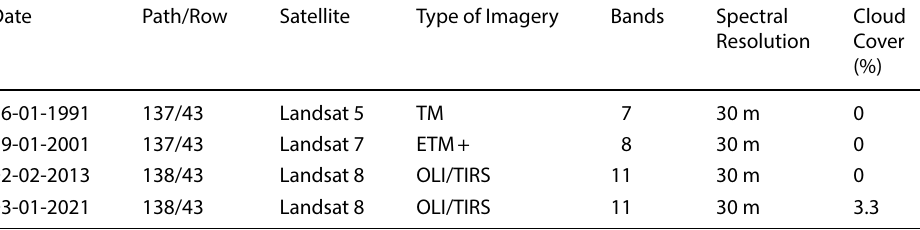
Table 1 Spectral characteristics of the satellite images used for LULC mapping in Jamalpur